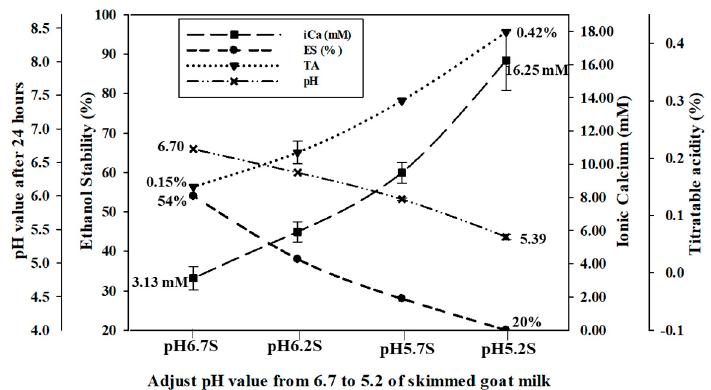
Figure 1. The e ff ect of the pH adjustment of skimmed Alpine goat milk on pH value after 24 h, titratable Figure 1. The effect of the pH adjustment of skimmed Alpine goat milk on pH value after 24 h, acidity (TA), ionic calcium concentration (iCa), and ethanol stability titratable acidity (TA), ionic calcium concentration (iCa), and ethanol stability (ES).